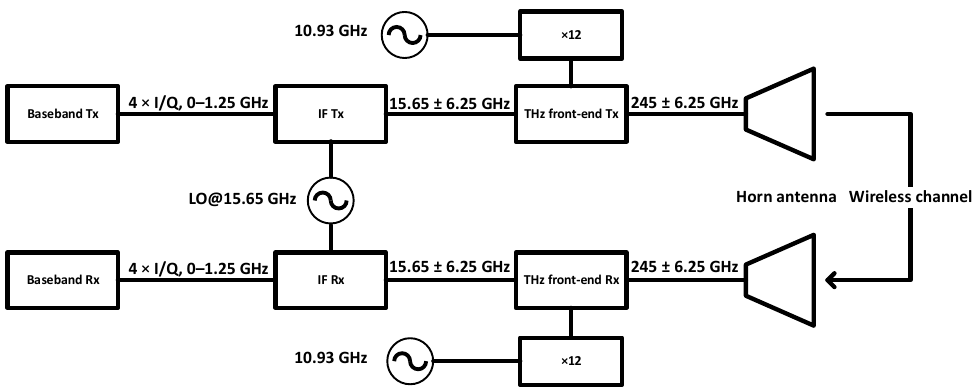
Figure 1. Configuration of the THZ wireless communication system.